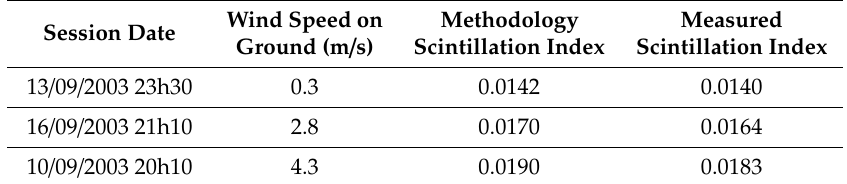
Table 3. Methodology Scintillation Index vs. Experimental Scintillation